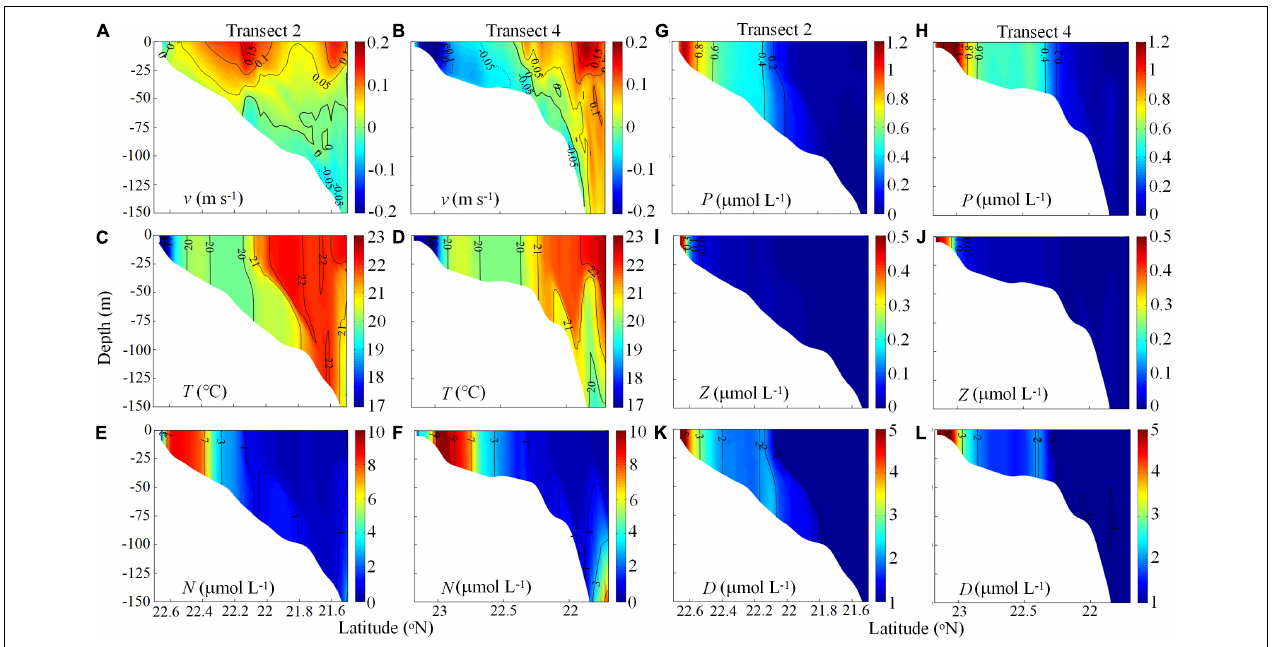
FIGURE 8 | Cross-shelf velocity ( v , m s − 1 ) (negative seaward) (A,B) , T ( ◦ C) (C,D) , NO 3 ( N , µ mol L − 1 ) (E,F) , phytoplankton ( P , µ mol L − 1 ) (G,H) , Z ( µ mol L − 1 ) (I,J) , and D ( µ mol L − 1 ) (K,L) along Transects 2 and 4 on Day 40.